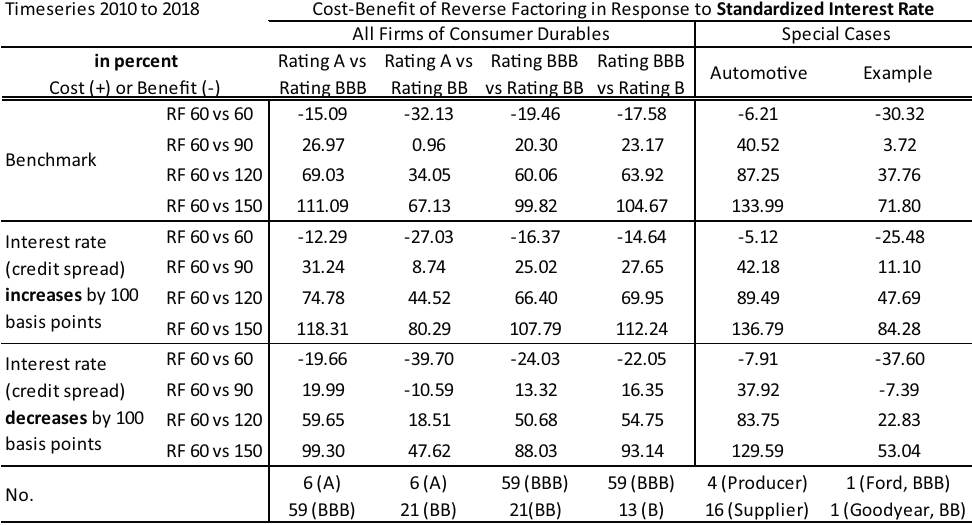
Table 3. Stylized simulation of 100 bp higher interest rates. Source: Authors’